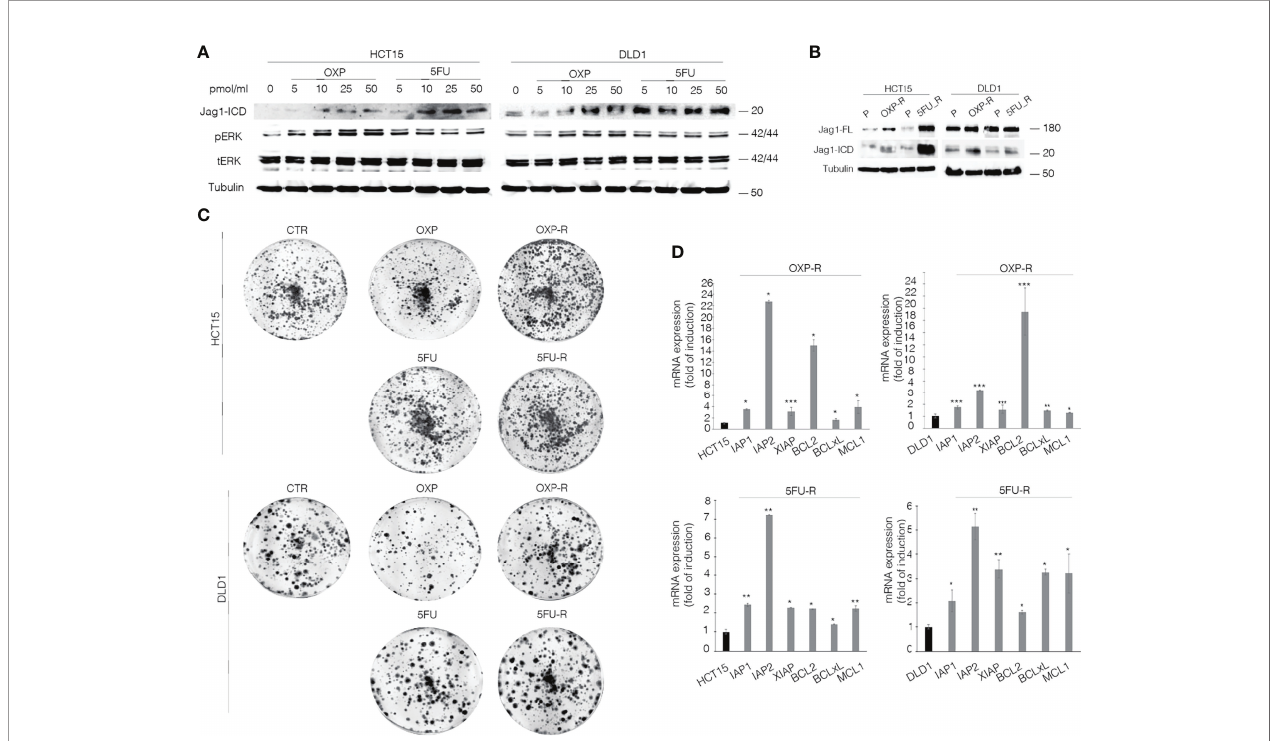
FIGURE 2 | OXP and 5-FU induce Jag1-ICD accumulation that drives CRC cells towards intrinsic drug resistance against the common chemotherapeutic agents. (A) Whole-cell extract from HCT15 and DLD1 cells, treated with OXP and 5FU with increasing doses (5 – 10 – 25 – 50 pmol/ m l) for 24 h, was subjected to immunoblotting analysis. (B) Parental (P), OXP-R, and 5FU-R CRC cells, were collected and subjected to immunoblotting assays as indicated. Tubulin was used as loading control. (C) Colony-forming ability of HCT-15 and DLD-1 cells or OXP-R and 5FU-R HCT-15 and DLD-1 cells in the presence of OXA and 5FU, compared with vehicle alone. A total of 2 × 10 3 cells were seeded in 6-well plates and treated with 0.5 pmol/ m l of OXP or 5FU for 15 days. (D) qRT-PCR analysis of iap1, iap2, xiap, bcl2, bclXl , and mcl1 mRNAs in parental (P), OXP-R, and 5FU-R CRC cells was performed. Data are reported as fold changes ± SD after intrasample normalization to the level of GAPDH . All data are representative of at least three independent experiments, each in triplicate. * p < 0.05; ** p < 0.01; *** p < 0.001 (Student ’ s t